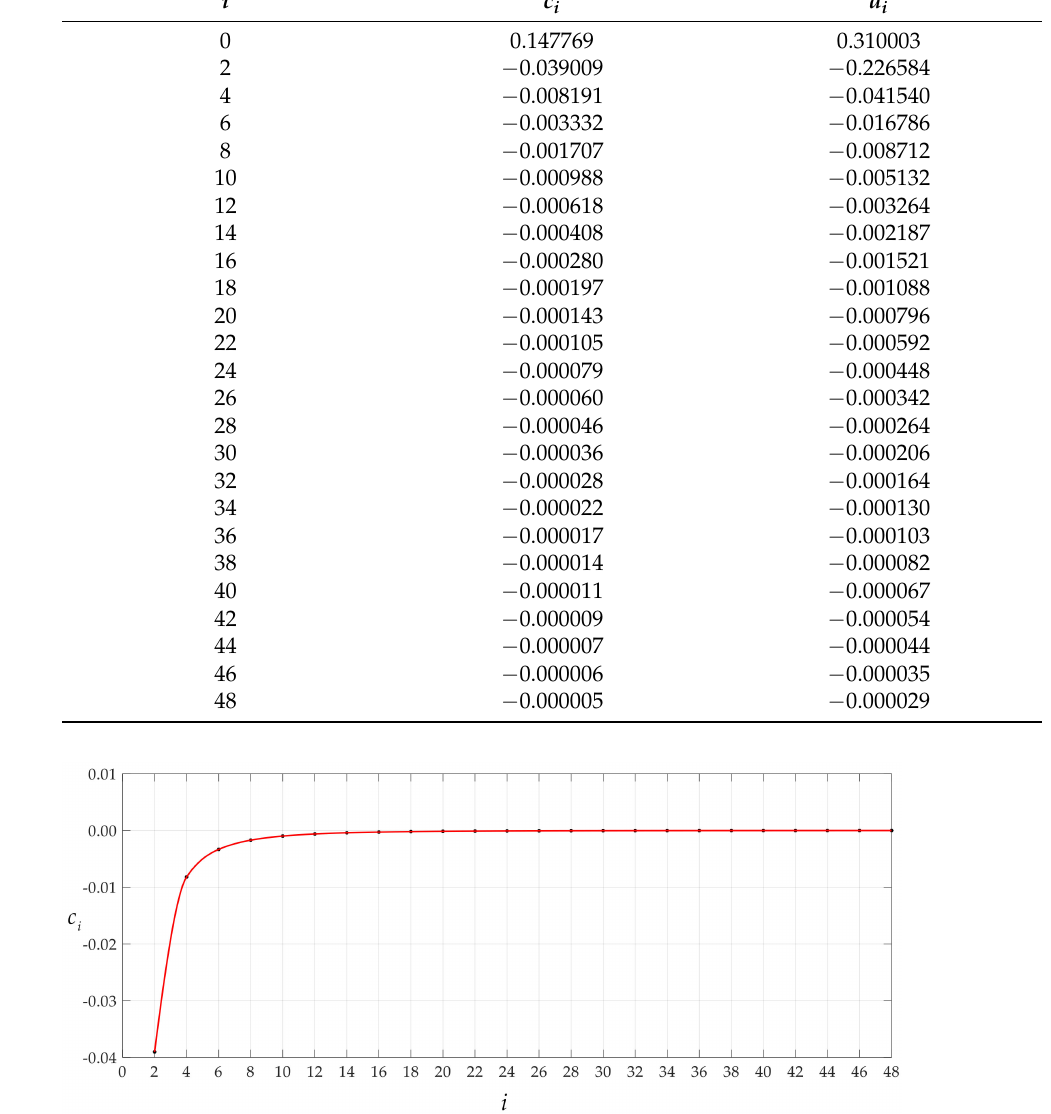
Figure 5. Variations of c i with i when q = 0.003 MPa and c 0 = 0.147769.